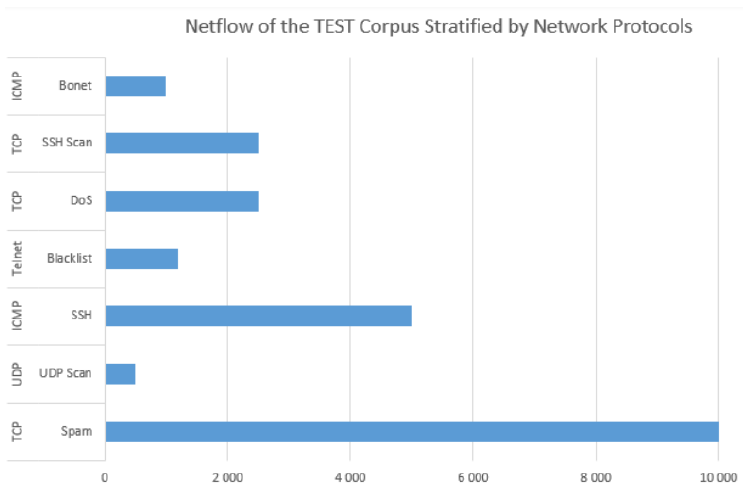
Figure 9. The TEST corpus of the UGR’16